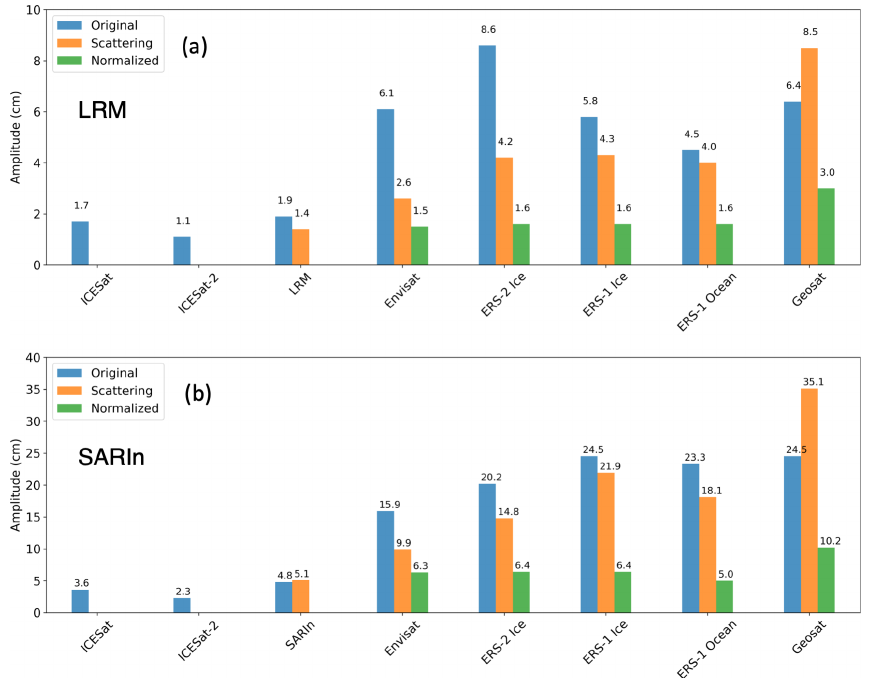
Figure 5. Median seasonal amplitude of the different missions and modes for the CryoSat-2 LRM (a) and SARIn (b) mode masks (south of 81.5 ◦ S for LRM). The blue bars show the original seasonal amplitude with no corrections applied, the orange bars show the amplitude once the mission-dependent scattering correction has been applied, and the green bars show the normalized amplitude after adjustment using CryoSat-2 as